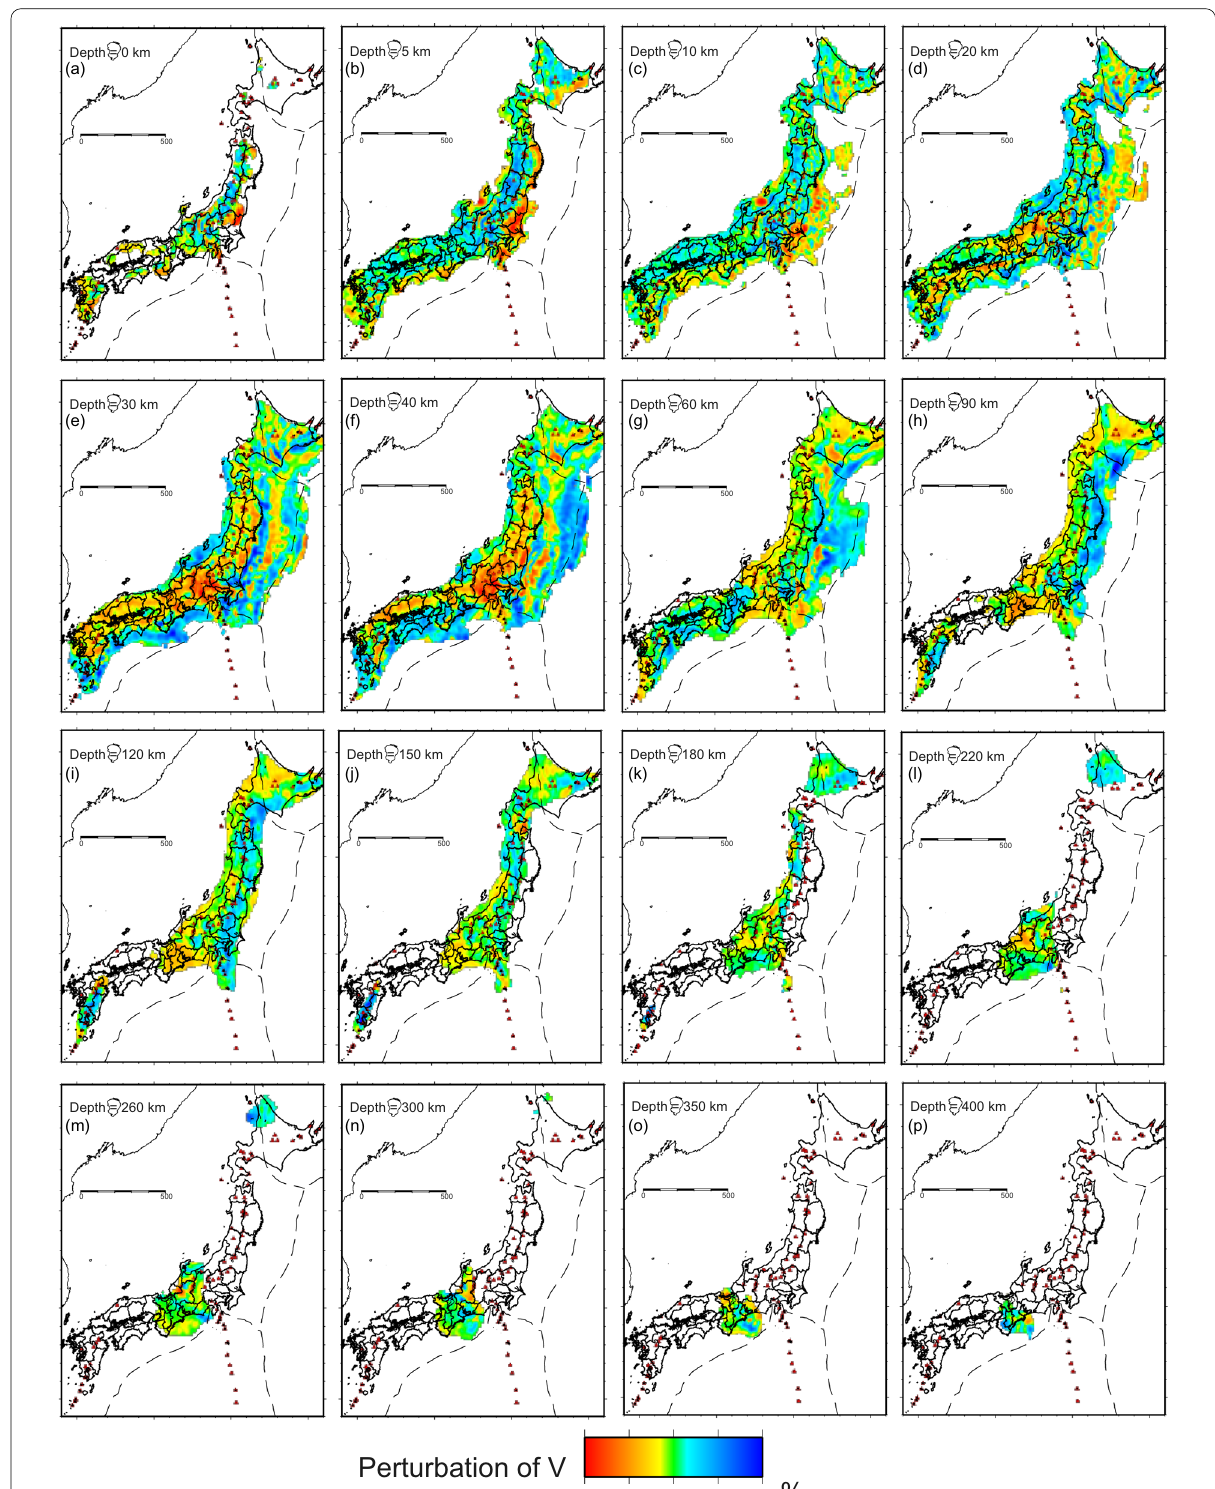
Fig. 13 Results of restored resolution test for